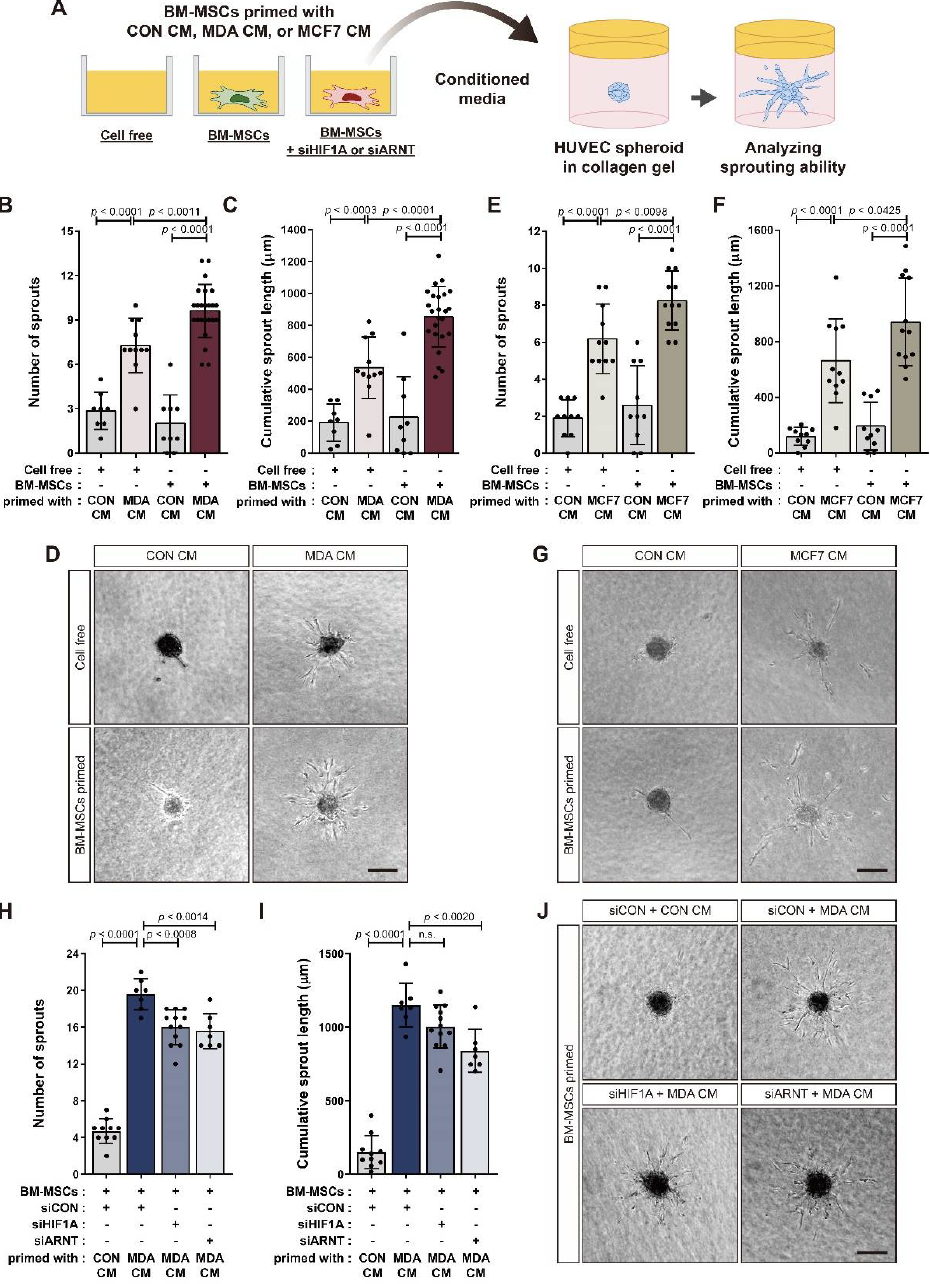
Figure 4. Increase in the angiogenic sprouting capacity of HUVEC spheroids in response to BM-MSCs primed with MDA CM or MCF7 CM: ( A ) Schematic representation of HUVEC spheroid- based sprouting angiogenesis assay. ( B – G ) Sprouting capacity of HUVEC spheroids incubated with conditioned media from BM-MSCs primed with CON CM, MDA CM, or MCF7 CM. ( H – J ) Sprouting capacity of HUVEC spheroids incubated with conditioned media from HIF-1α- or HIF-1β-knockdown BM-MSCs primed with CON CM or MDA CM. The number of sprouts per spheroid ( B , E , H ) and the total length of all sprouts originating from a single spheroid ( C , F , I ) were measured to quantify sprouting capacity. Representative images of each experimental condition are shown ( D , G , J ). Results are presented as the mean ± SD. Scale bar = 100 μm. n.s.: not significant.